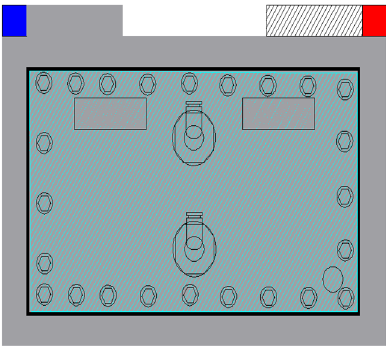
Figure 4. Side view of a hydrogen cell (Own study).